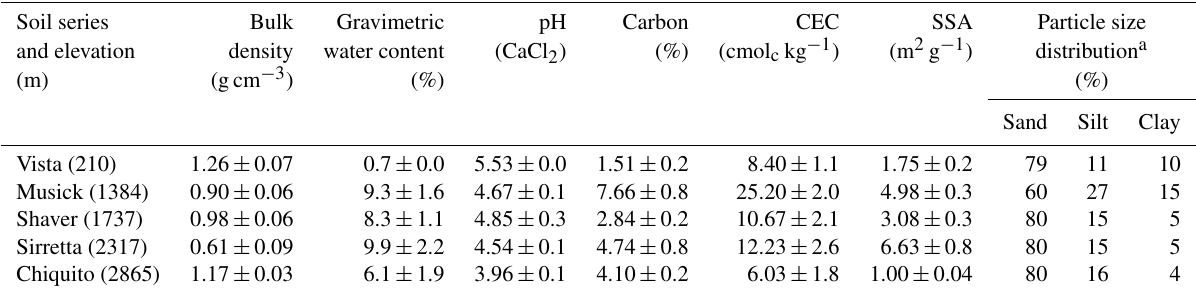
Table 2. Bulk density, water content, pH, C concentration, cation exchange capacity (CEC), specific surface area (SSA), and particle size distribution for the five soils (mean ± standard error, n =